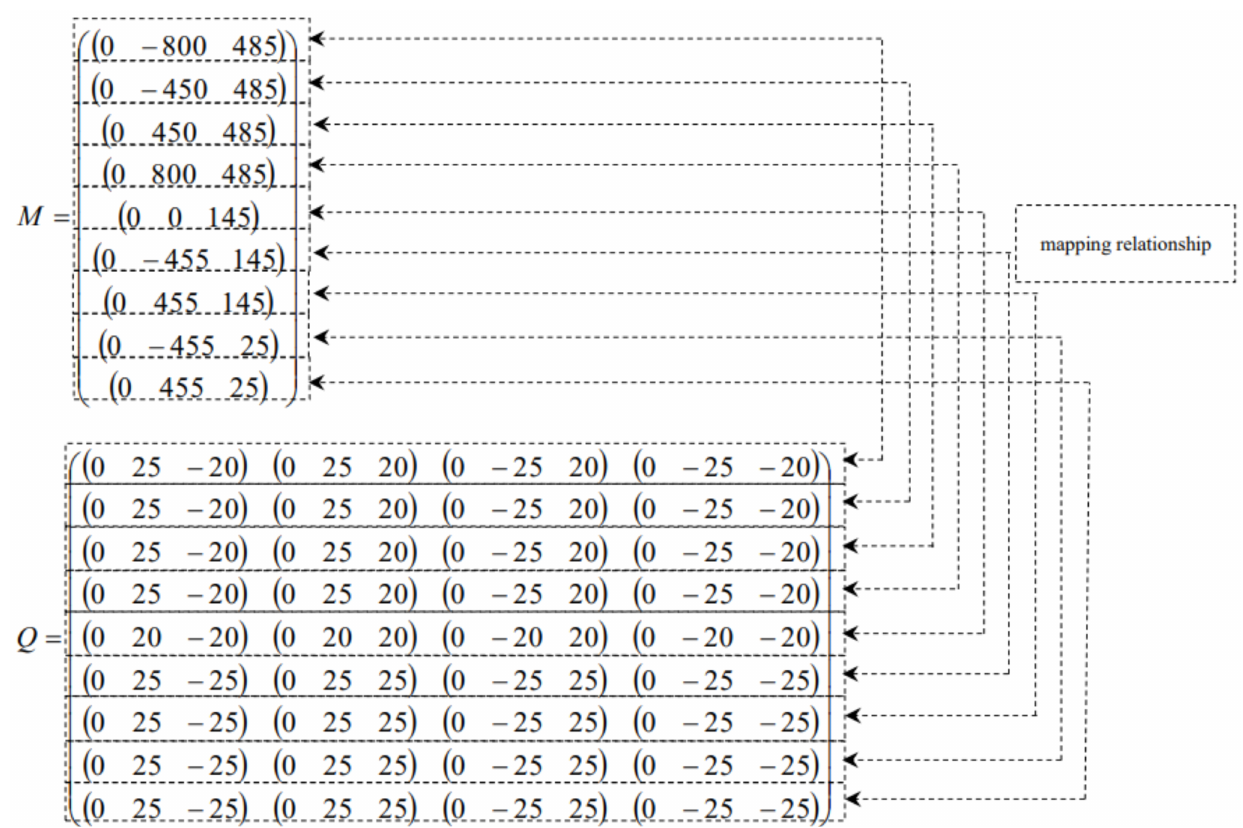
Figure 10. Digital expression model of the front interface of the middle frame module.